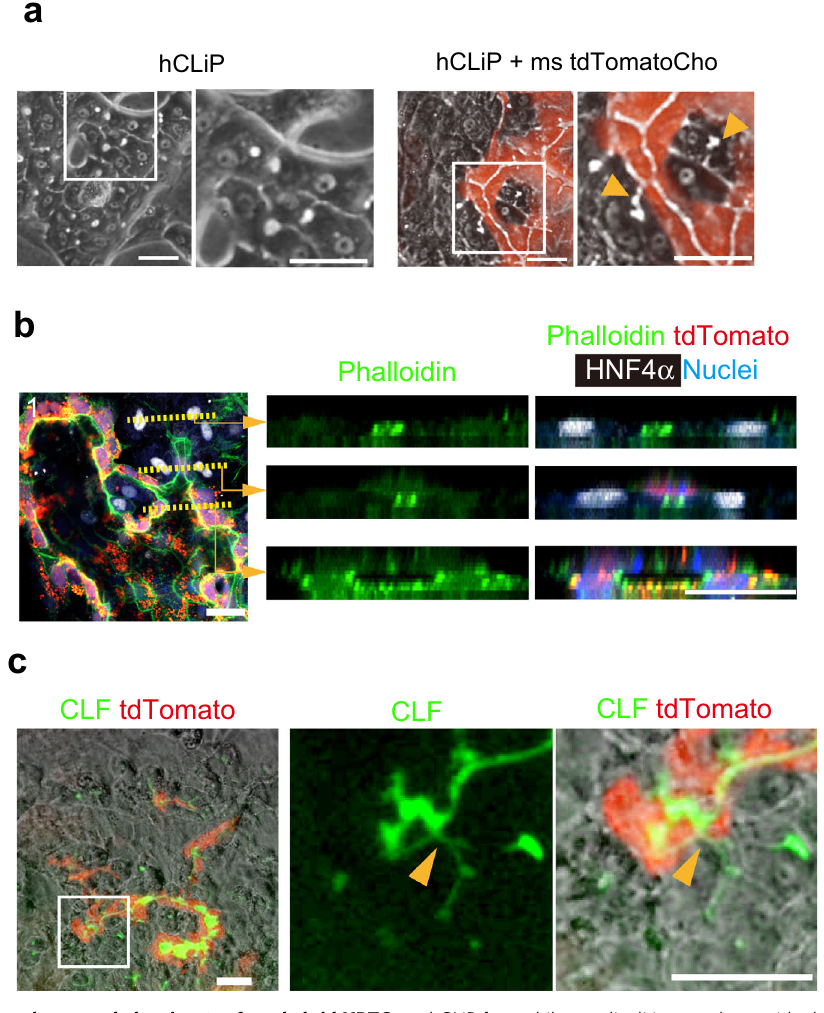
Fig. 6 Human hepatocytes and mouse cholangiocytes form hybrid HBTOs. a hCLiP forms bile canaliculi in co-culture with cholangiocytes. Bile canaliculi formed in co-culture are indicated by arrowheads. hCLiP and mouse tdTomato + cholangiocytes (Cho) were co-cultured to induce human-mouse hybrid HBTOs. Coculture was repeated four times. Three fi elds were examined in each well and the representative images are shown in this fi gure. Boxes are enlarged in the neighboring panels. Bars represent 40 μ m. b Hepatobiliary junction in a hybrid HBTO. Optical cross-sections along broken lines in the left panel are shown in the right panels. The bile canaliculi in an HNF4 α + hepatocyte cluster (upper right panels) is connected to the lumen of a tdTomato + mouse biliary structure (lower right panels) via the luminal structure surrounded by HNF4 α + hepatocytes and tdTomato + mouse cholangiocytes (middle right panels). The immunostaining with phalloidin (green), anti-HNF4 α antibody (white), and Hoechst 33342 (blue) was repeated four times independently. Four fi elds were examined in each sample. Three out of sixteen fi led were further analyzed to collect serial optical sections for 3D reconstruction. The representative images are shown in this fi gure. Bars represent 20 μ m. c Hybrid HBTOs take up CLF and transport it to the biliary tissue. CLF taken up by hCLiP is transported to the biliary tissue consisting of tdTomato + mouse cholangiocytes. The hepatobiliary connection is indicated by arrowheads. Experiments were repeated twice, independently. Four different fi elds were examined in each sample and the representative images are shown in this fi gure. The box in the left panel is enlarged in the middle and right panels. Bars represent 50 μ